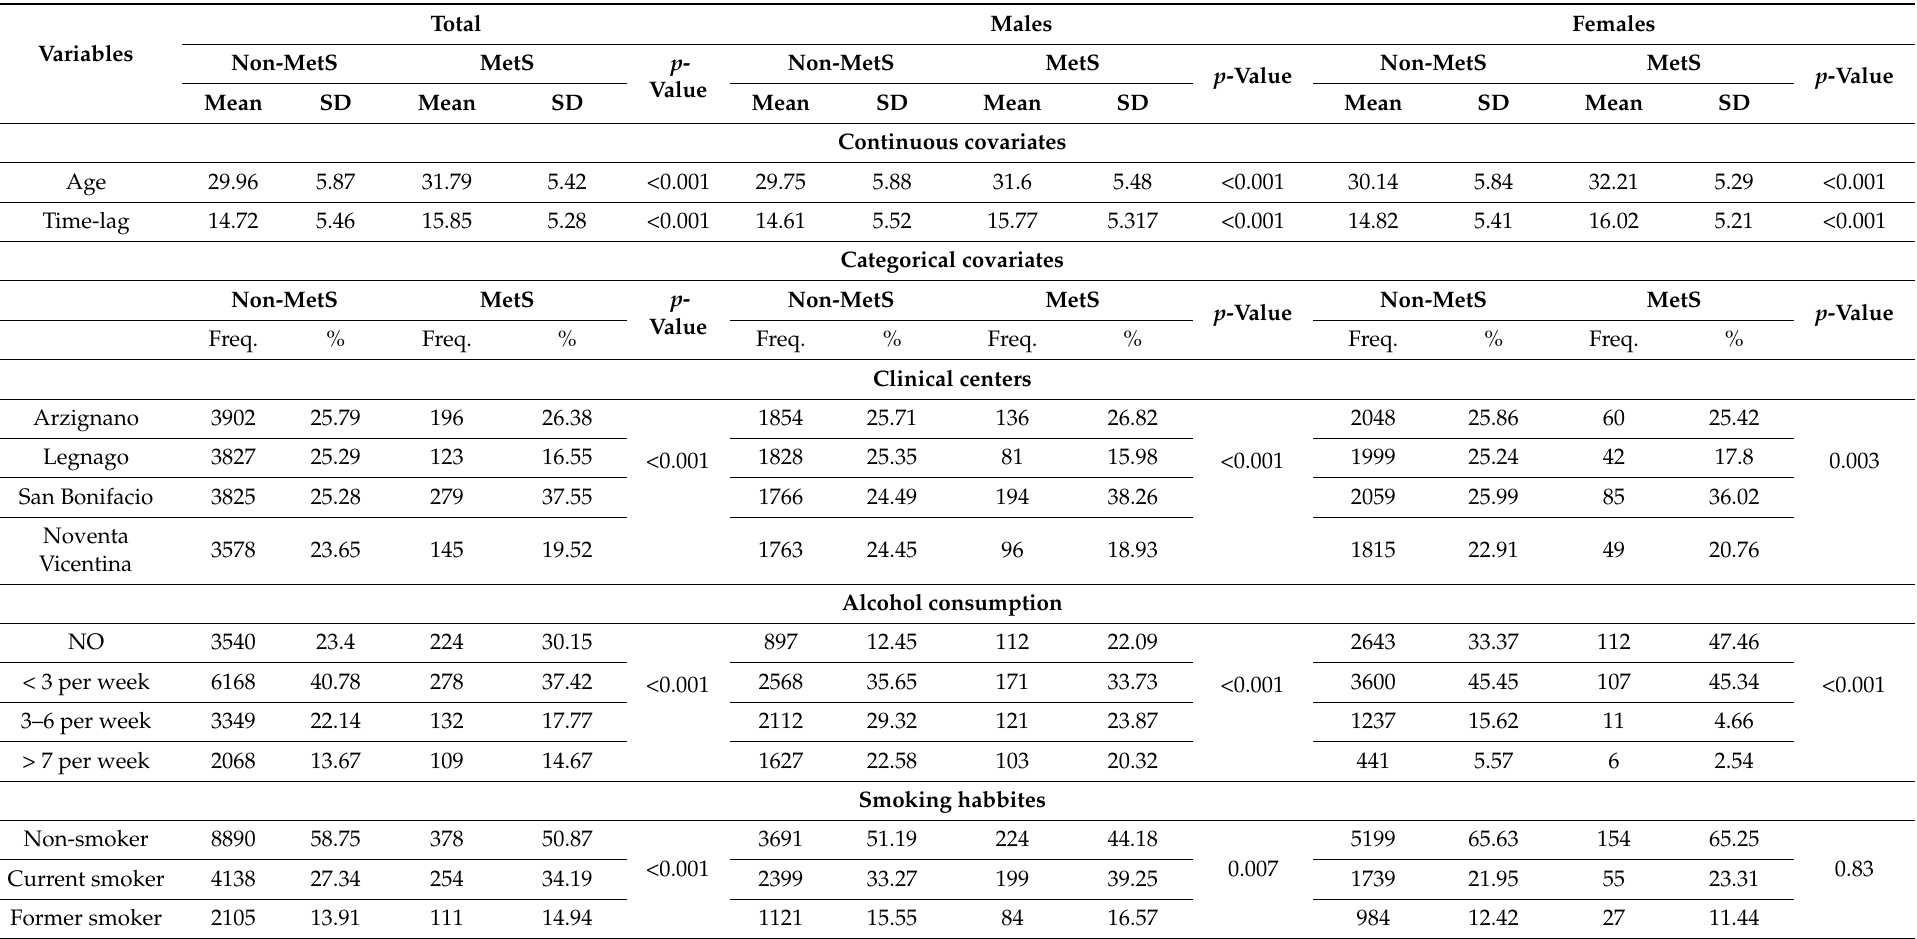
Table 2. Distributions of the covariates in the study population ( n = 15,876) according to metabolic syndrome (MetS) status for harmonised definition (JIS) stratified by gender. Total Males Variables